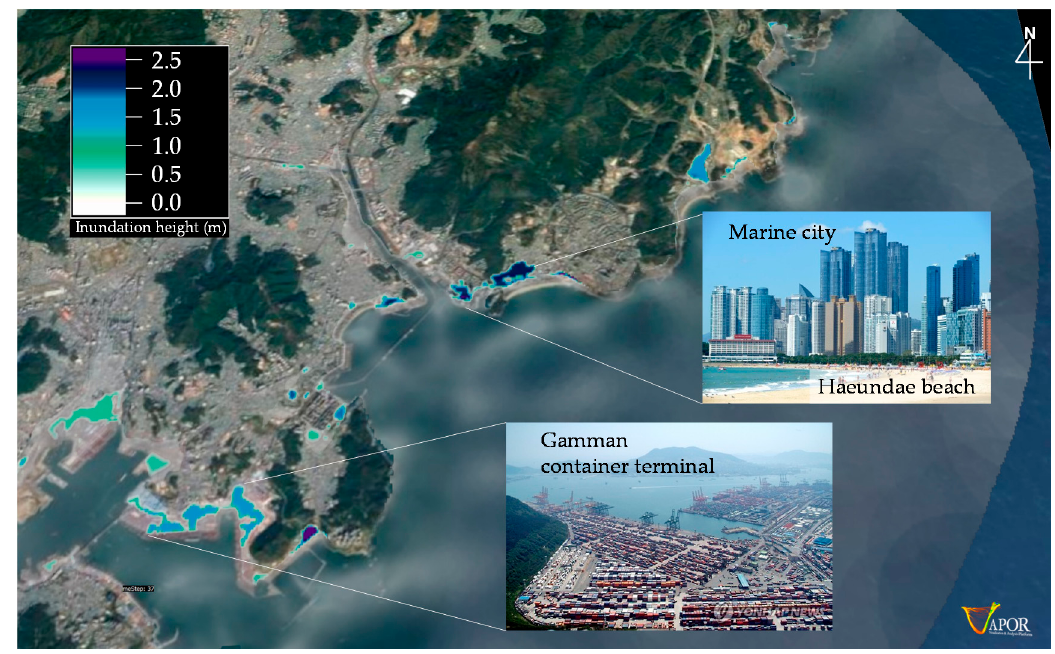
Figure 11. Visualization of coastal inundation results on the South coast near Busan city.